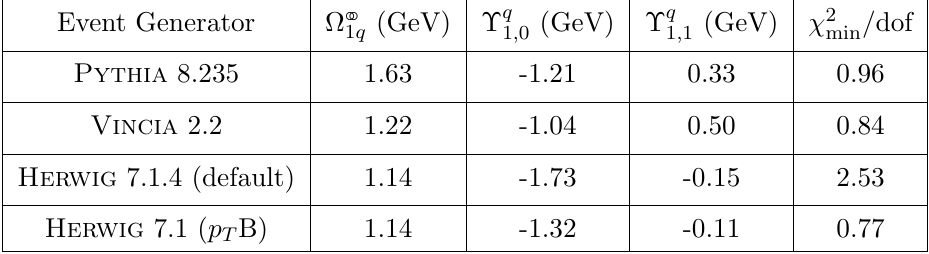
/dof following the method described in min